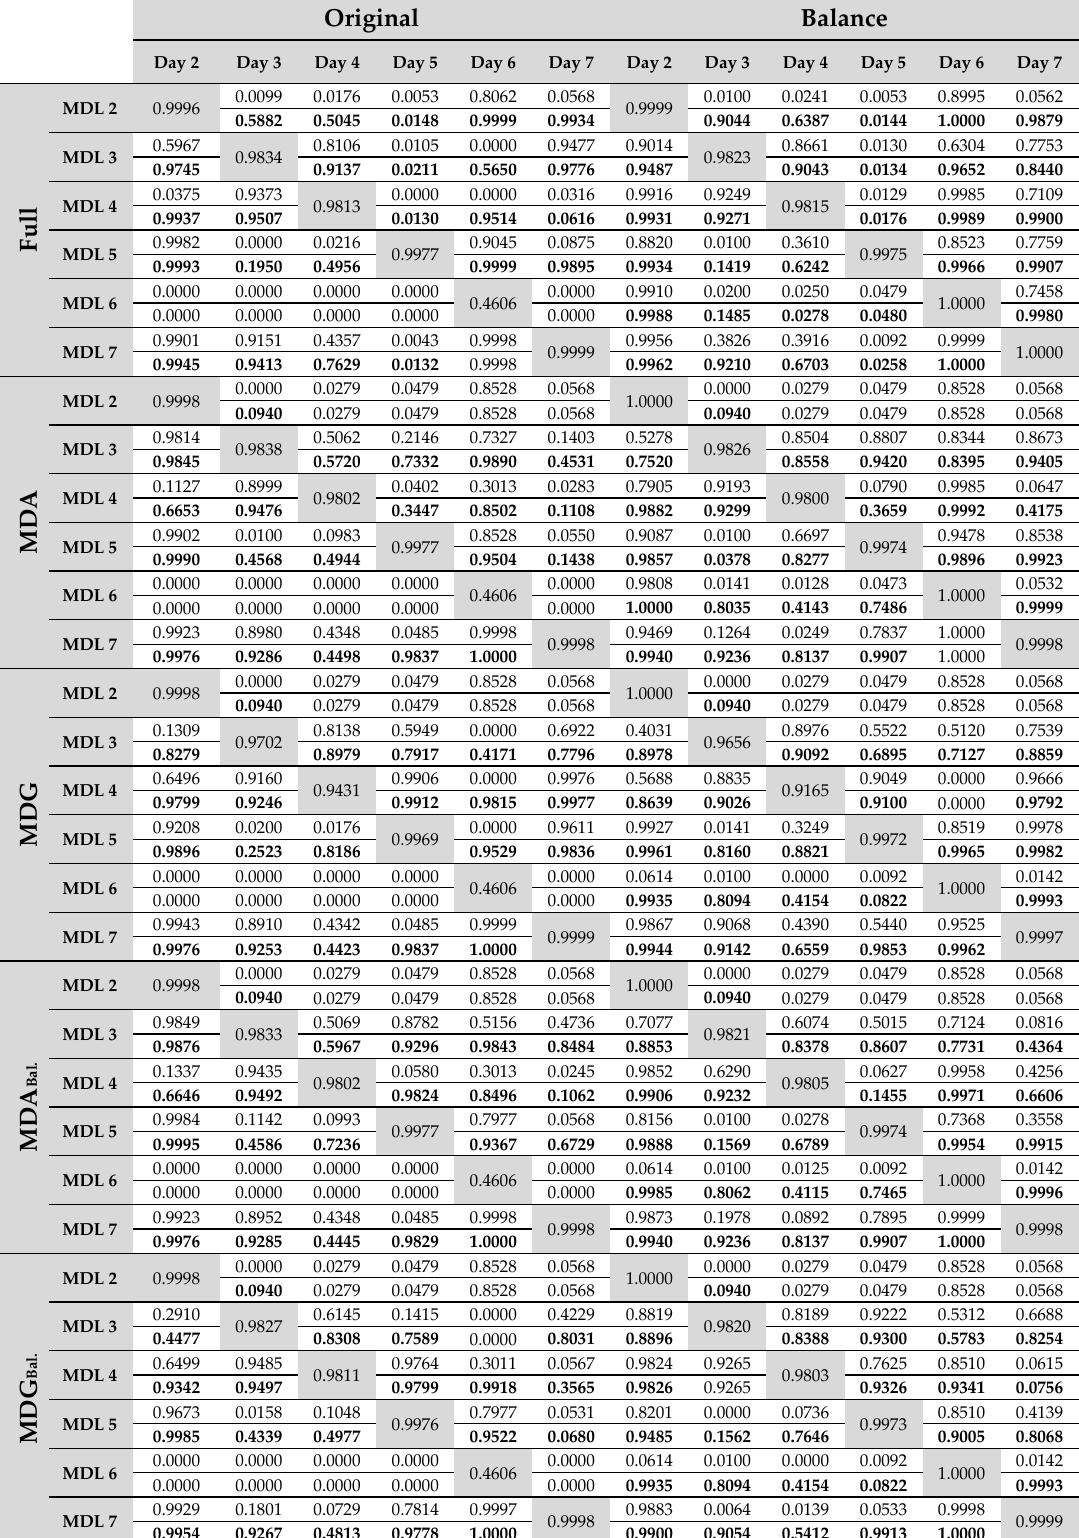
Table A4. The gAcc of models for the fixed optimal (CV) and adapted cut-off (threshold) for the C5.0 algorithm.